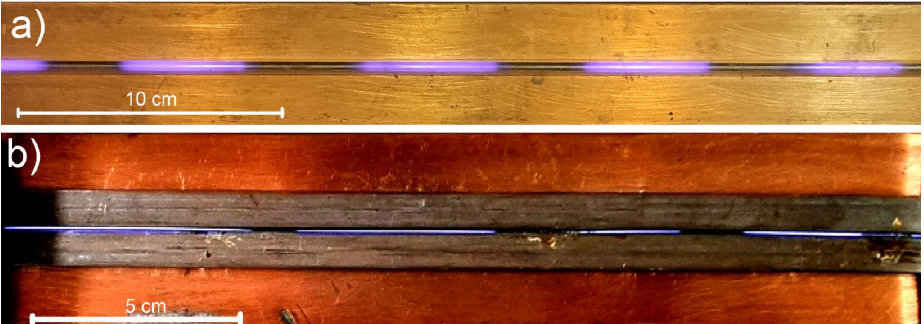
Figure 5. Microwave discharge in a capillary ( a ) and in a revolver HCF ( b ) filled with argon at a pressure of 20 Torr against the background of the side surface of the waveguide with a slot in the middle. A capillary with an inner diameter of 3 mm is placed directly into a slot; revolver fiber with a core diameter of 120 μm is placed between special pads that reduce the effective slot width. A standing wave was formed in the microwave waveguide due to the interference of the incident and reflected waves from the short-circuiting plunger. The quality of the interference pattern depended on the parameters of the plunger setting.